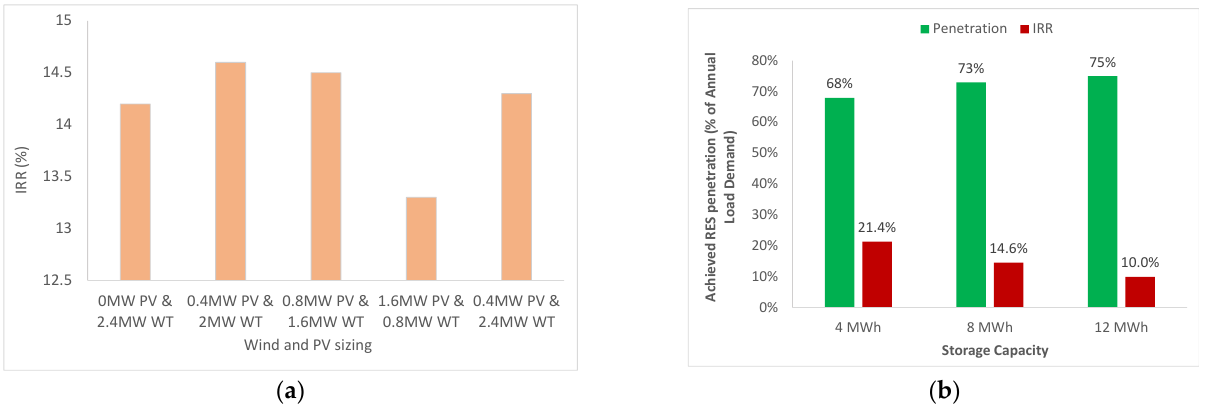
Figure 2. ( a ) Internal rate of return (IRR) for different RES capacity combinations in Astypalea; ( b ) IRR and achieved RES penetration for different storage capacities [14].